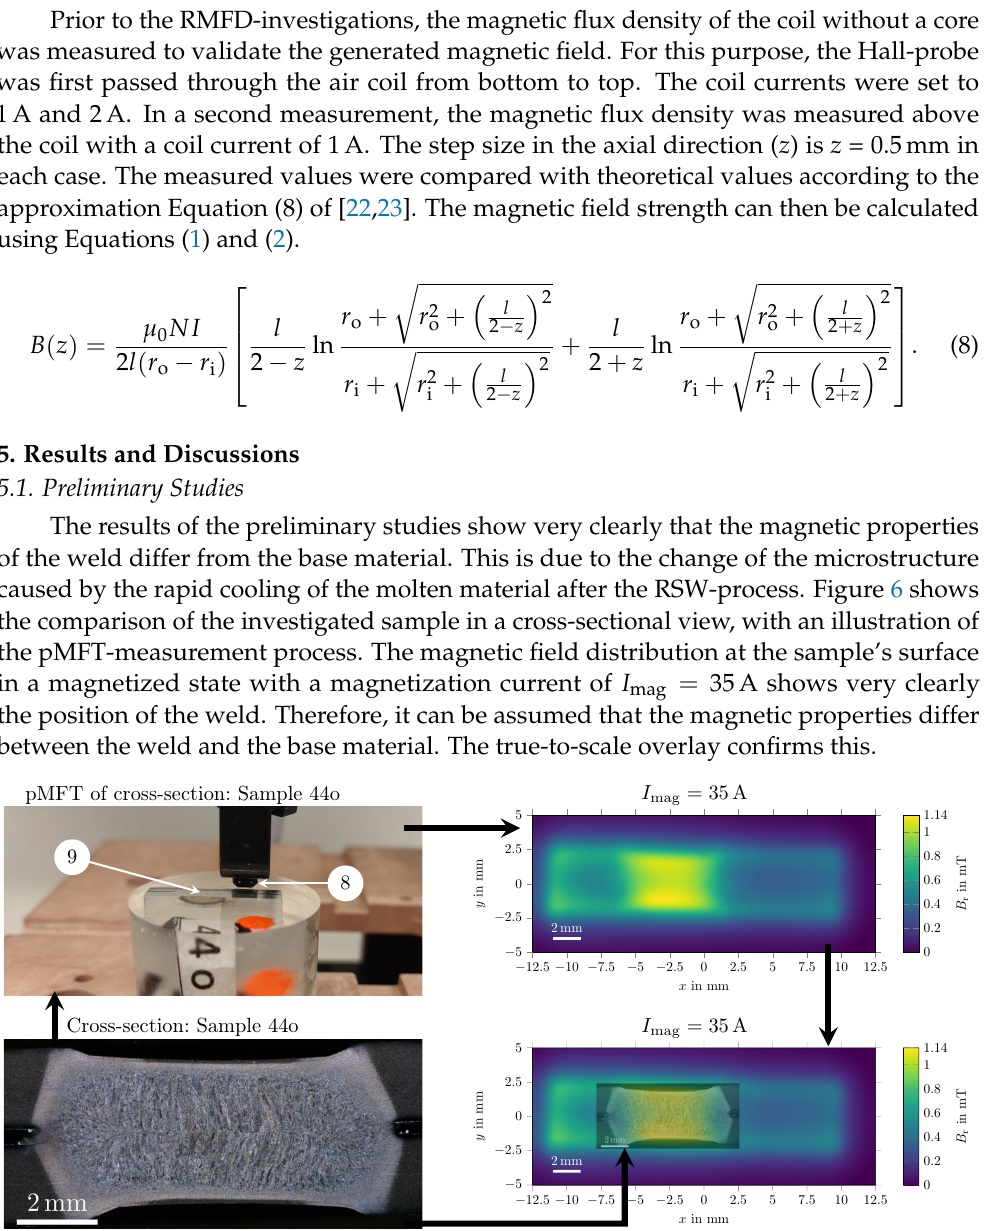
Figure 6. Comparison of the cross-section specimen with clear representation of the weld nugget ( bottom left ). A view of the pMFT-measurement with the Hall-probe (8) and the cross-sectional sample (9) ( top left ), and the results of the flux density measurements after magnetizing the specimens with 35A ( top right ), and the true-to-scale overlay of the cross-section with the magnetic field distribution ( bottom right